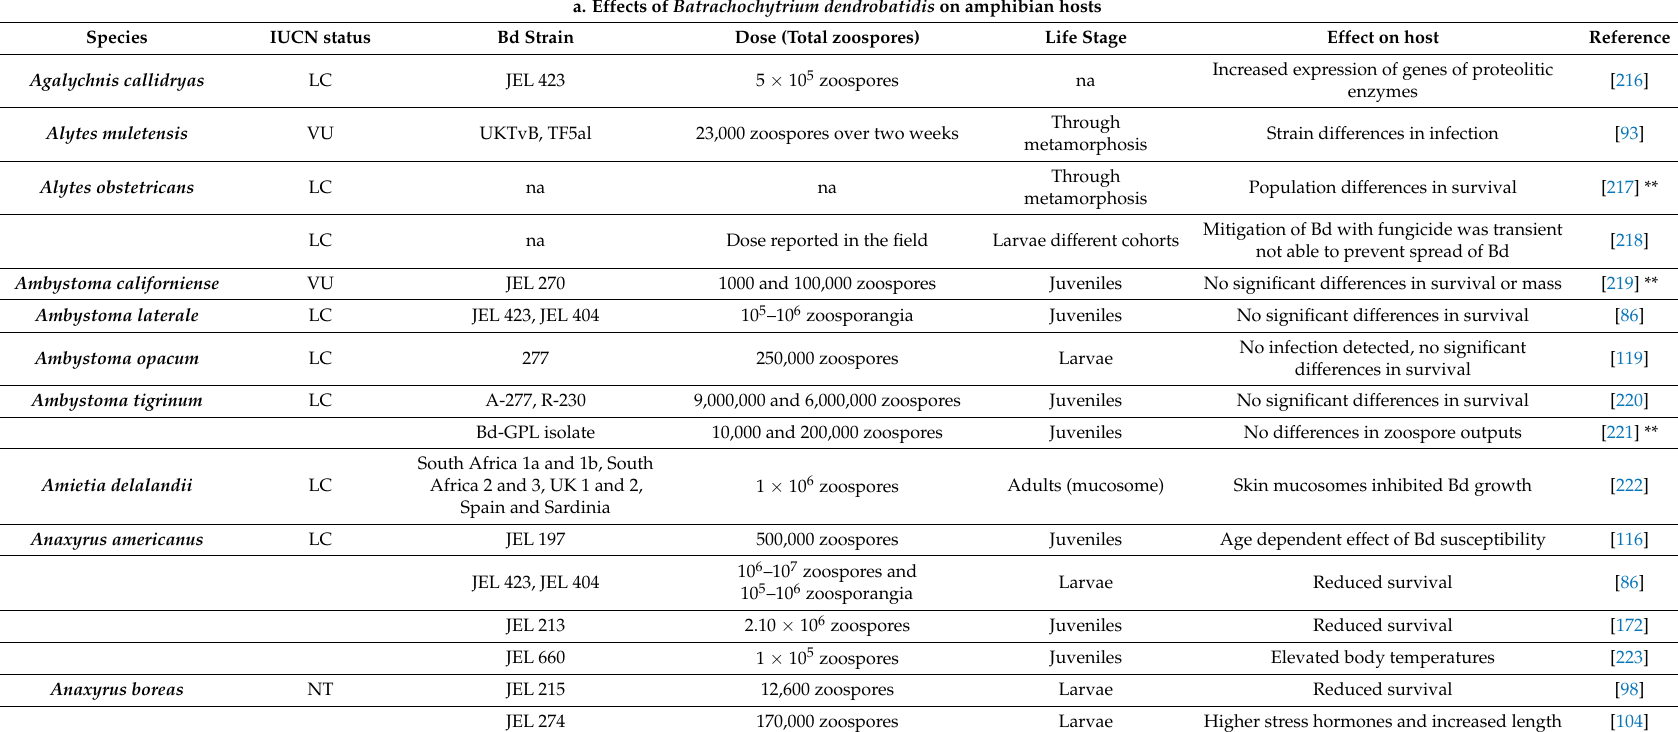
Table 1. An overview of the effects of Bd ( a ), Bsal ( b ), and Rv ( c ) on amphibian species based on experimental studies. Publications were compiled using the search strings “ Batrachochytrium dendrobatidis and amphibian s”, “ ranavirus and amphibians ” and “ Batrachochytrium salamandrivorans and amphibians ” in the Web of Science database from which duplicates and articles that were unrelated were removed. If one publication examined multiple species or host life stages, each species and life stage was reported separately. We have included each species International Union for Conservation of Nature (IUCN) Red List Status (http://www.iucnredlist.org), a widely recognized mechanism for assessing conservation status. Species of Least Concern (LC), Near Threatened (NT), Vulnerable (VU), Endangered (EN), and Critically Endangered (CE). na = not available. Reduced survival means mortality of hosts exposed to a pathogen was significantly higher than hosts in controls that were not exposed to a pathogen. * animals were not reared from eggs. ** animals were not reared from eggs but were verified as Bd or Rv negative before the start of the experiment. *** collection information